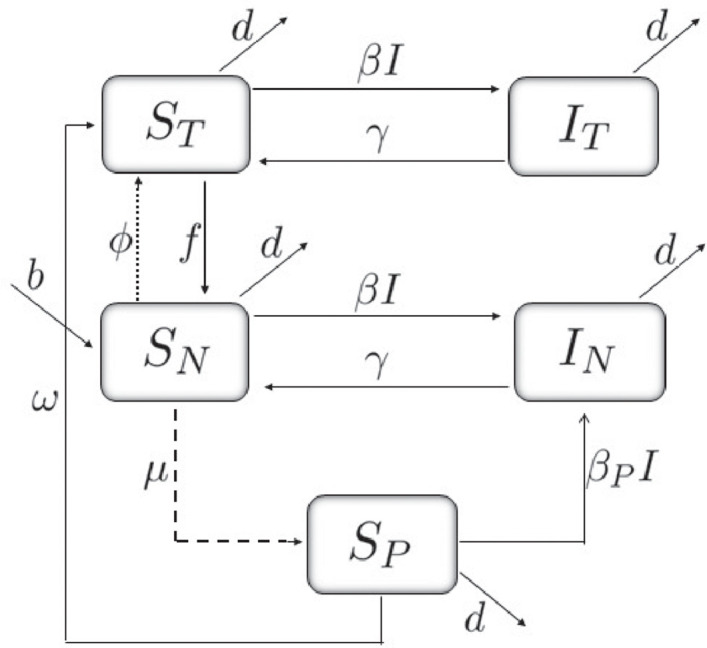
Dynamics of the states in which an individual can be found.I = IT + IN. The segmented line corresponds to the pulse of the pesticide application and the dotted line to the pulse modeling the effects of the educational campaign.